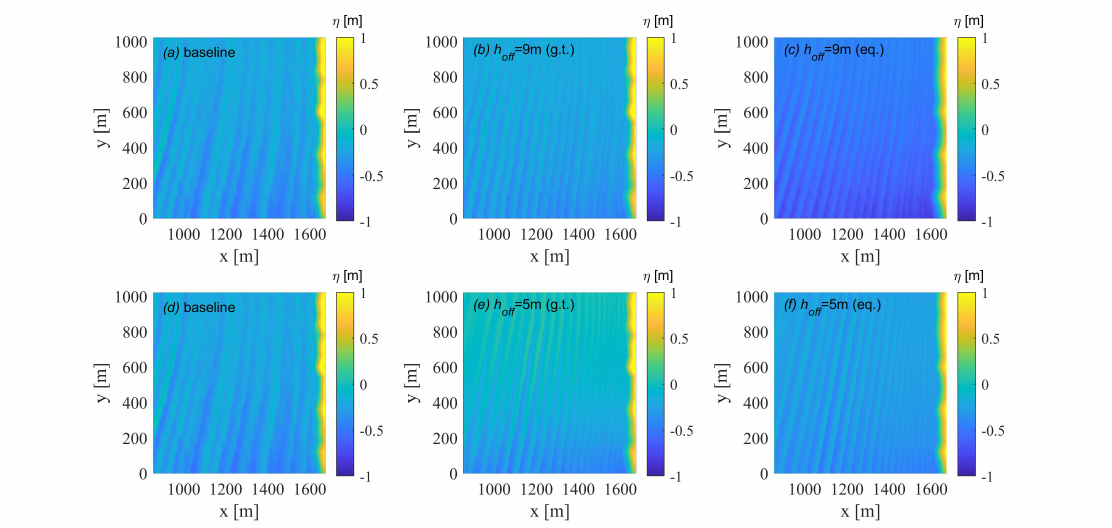
Figure 10. Free-surface level at t = 1000 s ( ∼ 135 waves) for the ESE tests: baseline simulation ( a , d ), flood simulations with boundary condition at h ≈ 9 m ( b , c ) and at h ≈ 5 m ( e , f ). Ground-truth-based ( b , d ) and equilibrium-based ( c , f ) tests.